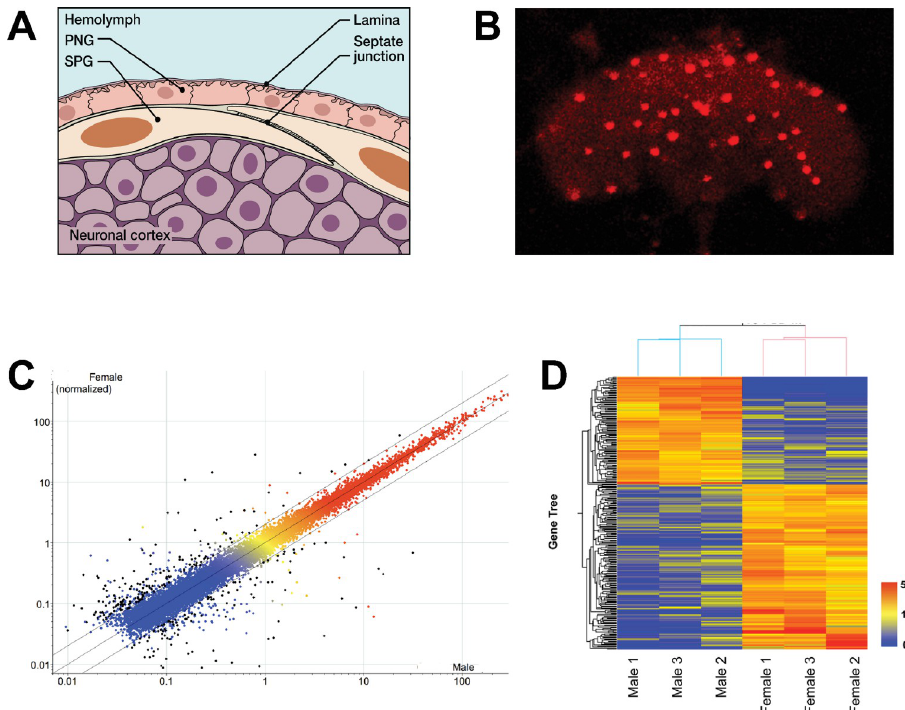
Fig 1. Microarray analysis of isolated SPG cells of the BBB. (A) Schematic of the Drosophila Blood Brain Barrier (BBB). The BBB consists of two layers of glial cells, the outer Perineurial Glia (PG) facing the circulating hemolymph, and the inner Subperineurial Glia (SPG) with septate junctions that form the main barrier. The SPG is in contact with the underlying nuclei of the neuronal cortex. (B) Isolated fly brain with SPG cells labeled by nuclear DsRed expression driven by SPG-Gal4 . Fluorescently marked cells like these from males and females were hand-isolated for RNA extraction. 20x Magnification. (C) Probes present (above background) in all male or female samples are displayed as normalized to the 75th percentile intensity of each array (19,218 probes). Each spot is the mean of 3 samples from each condition. Black spots = differentially expressed genes ( > 2Fold, T-test p-value < 0.05, 284 probes). Red/orange = High expression, Yellow = Medium expression, Blue = Low expression. (D) Differentially expressed genes ( > 2 fold, T-test p- value < 0.05) in Male vs. Female are displayed as normalized to the median value of each probe across six samples (284 probes). The heat map color scale is shown on the